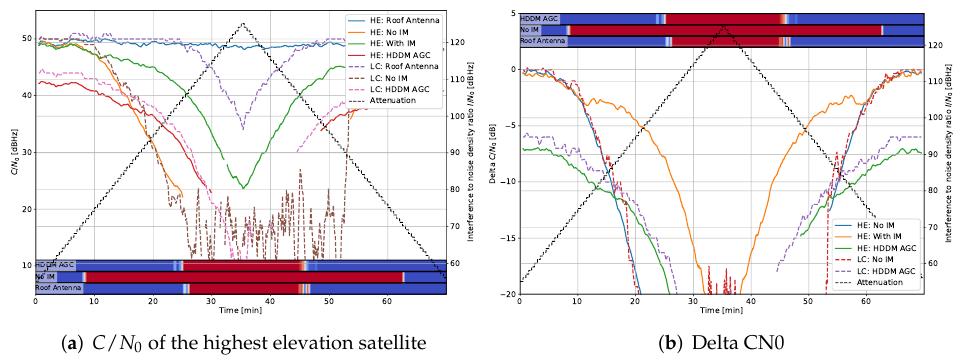
Figure A13. Interference #4: Fast frequency hopper with a dwell time of 1us and a frequency range of 35MHz with Galileo E1BC.